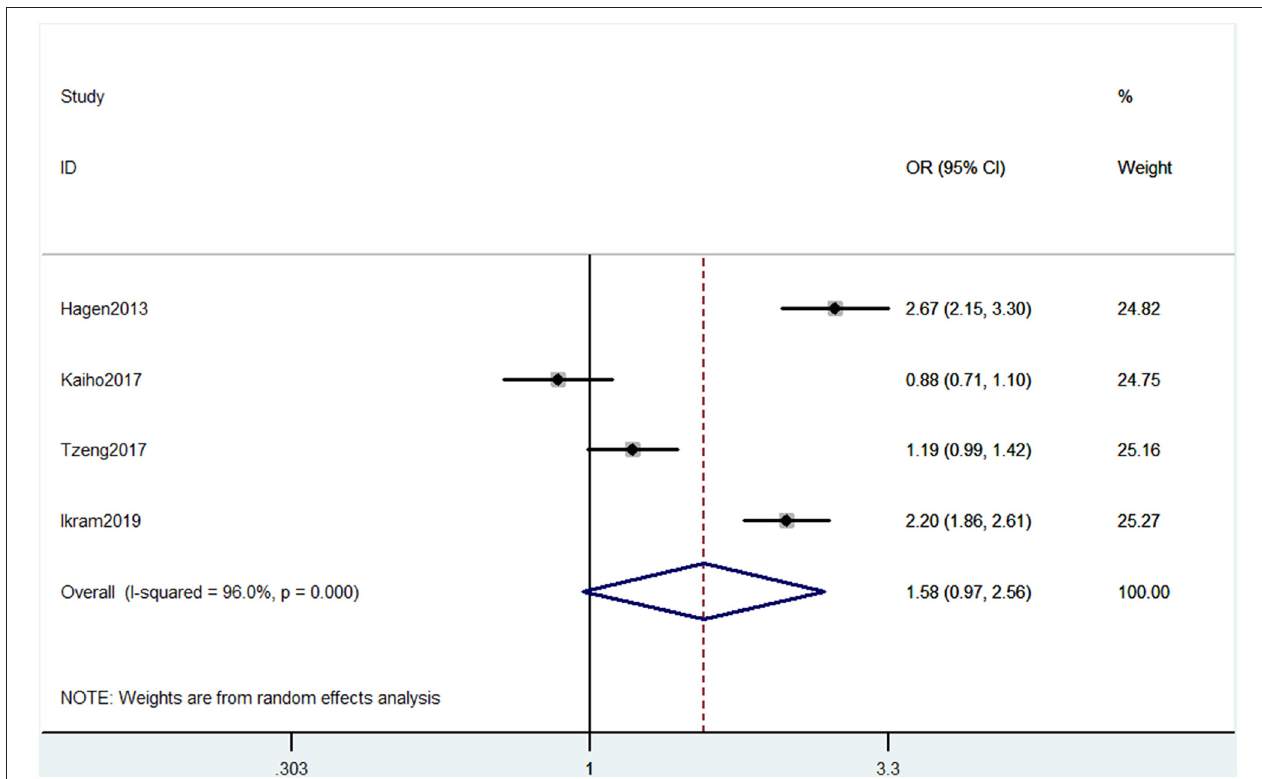
FIGURE 6 | Forest plot of the OR and 95% CI from a random-effects meta-analysis for the association between chronic pain and incidence of cognitive decline when ICD was used. The rhombi represent the pooled OR for this association.